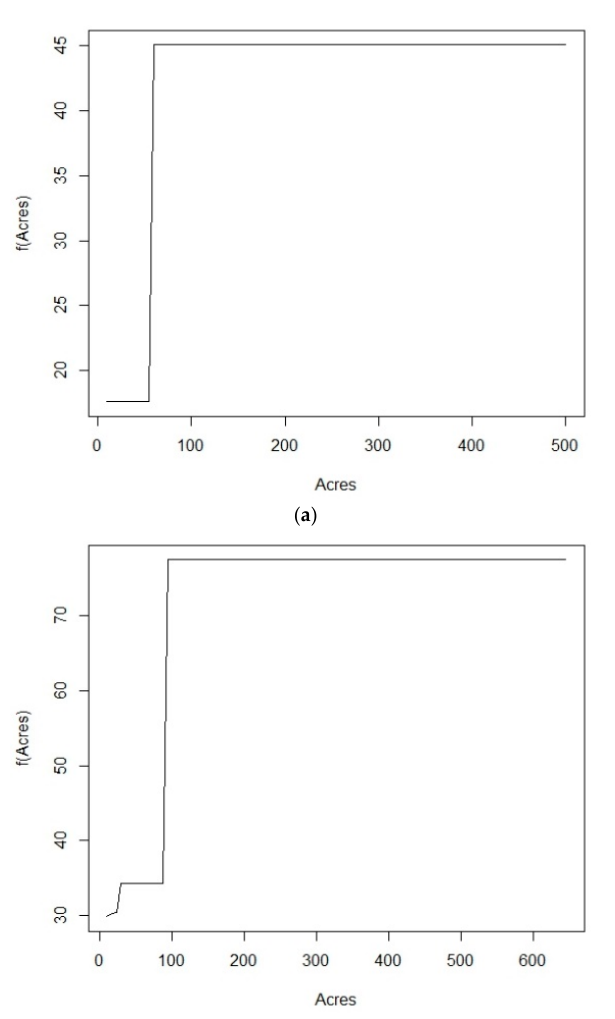
Figure 9. Partial dependence plots for acres variable for the two models; acres to produce ( a ) and acres to rent ( b ).